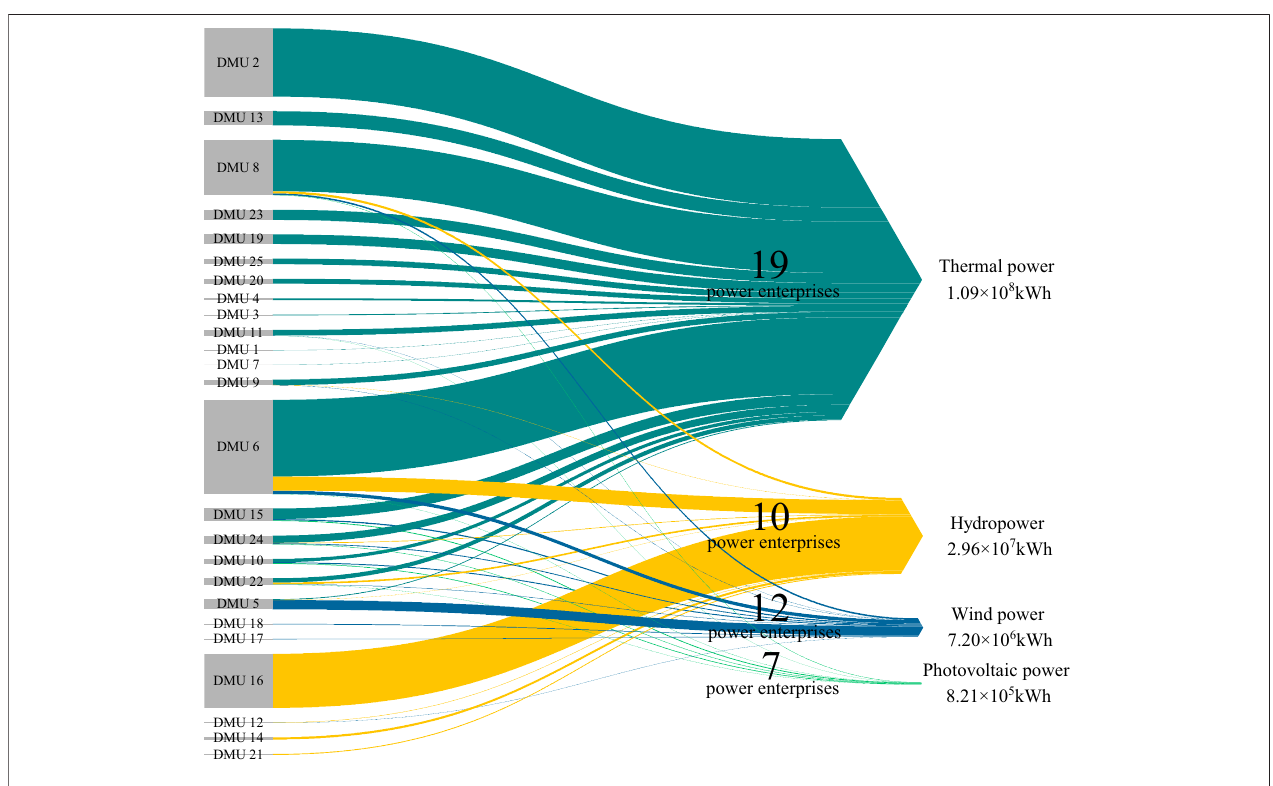
FIGURE 3 | Power generation capacity of power enterprises in